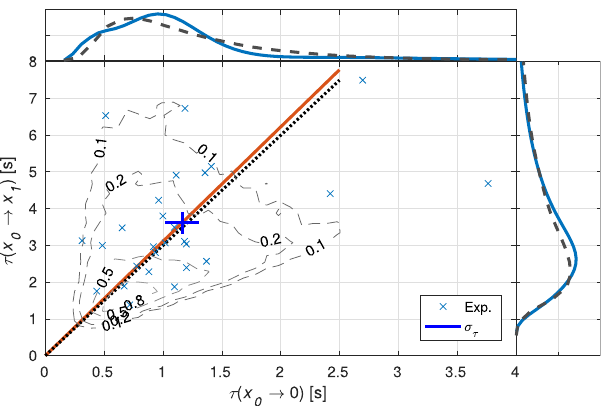
Figure 4. First-passage times and the ratio R = 〈 τ ( x 0 → 0) 〉 )/( 〈 τ ( x 0 → x 1 ) 〉 . Light blue × marks the first-passage time experimentally determined for each trajectory. The intersection of thick blue lines depicts the mean first- passage times 〈 τ ( x 0 → 0) 〉 ( x -axis) and 〈 τ ( x 0 → x 1 ) 〉 ( y -axis) and the lengths of blue lines denote standard errors 1 2 1/2 . Full red line passing through the blue cross and the dotted black of the both means, i.e. τ τ ∑ − ⟨ ⟩ [ ( ) ] − ( 1) N N i line depict the measured ratio R = 0.32 and theoretically predicted value of R = 1/3, respectively. Comparison of trajectories start at x 0 = 1.2 μ m and end in 0 or x 1 = − 2.1 μ m, see Fig. 1. Side panels show the first-passage time probability density function (blue curves) applying the kernel smoothing function on the experimental data and the probability density function calculated from the simulated data (dashed